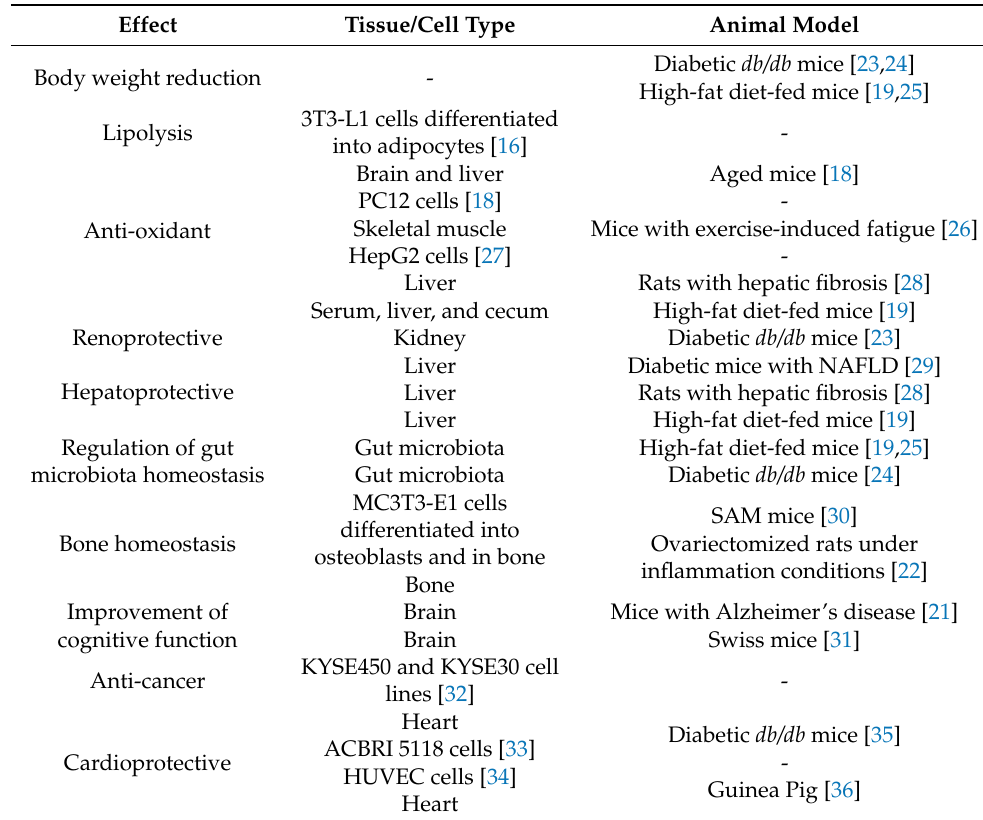
Table 1. Cont. Effect Tissue/Cell